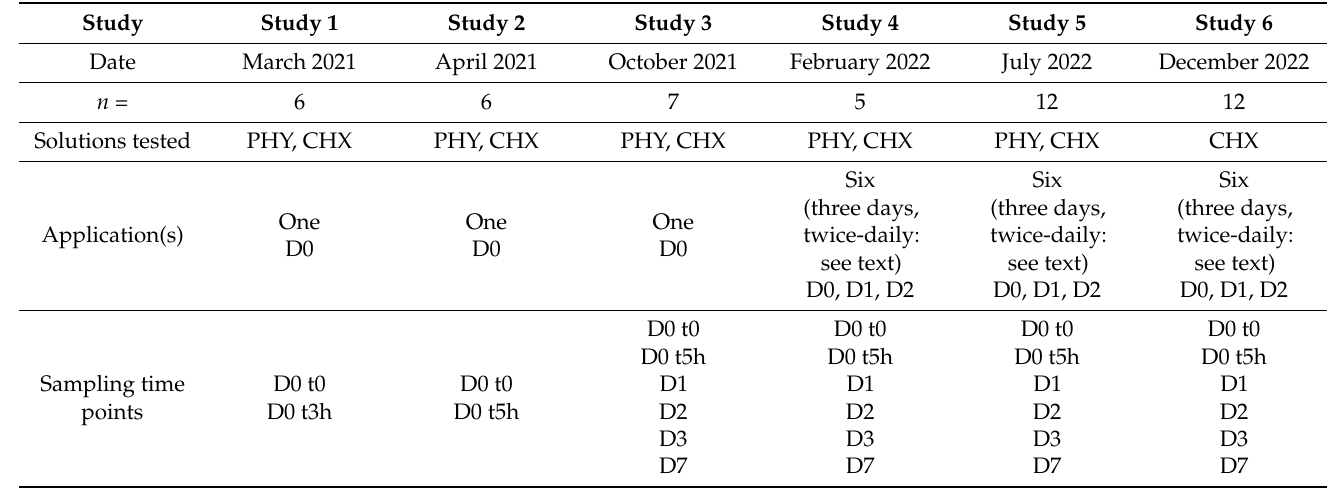
Table 1. Study design. PHY: physiological saline; CHX: Chlorhexidine. Sampling times: just before application of the relevant solution (D0 t0), and then 3 h (D0 t3h) or 5 h (D0 t5h), 1 day (D1), 2 days (D2), 3 days (D3), and 7 days (D7) after the first application of the relevant